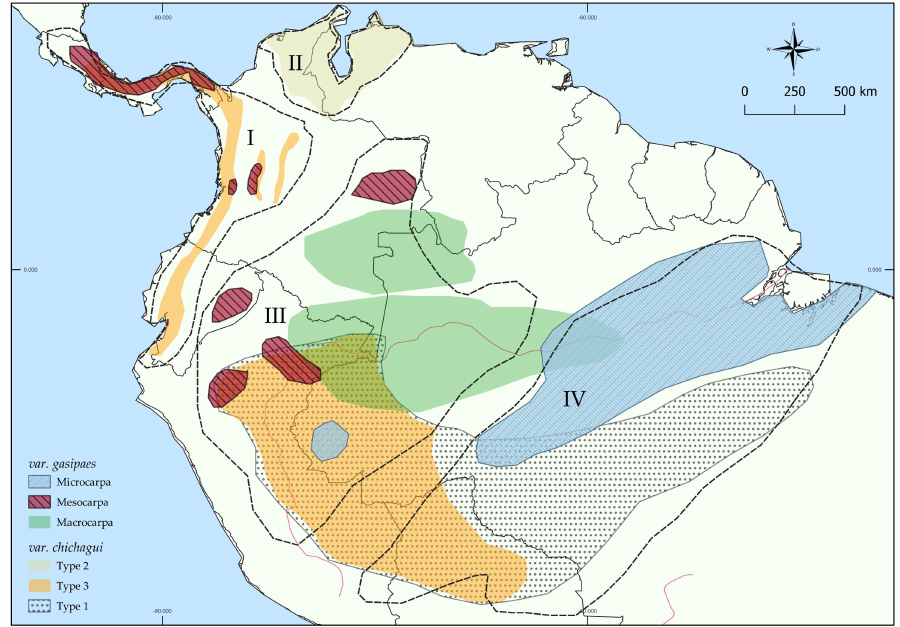
Figure 1. Distribution of B. gasipaes through Central and South America (adapted from Clement et al. [18] and Hern á ndez-Ugalde et al. [20]). The dashed lines comprehend the four main complexes: I. Occidental group: composed of representants of var. chichagui (Upala, Azuero, Dar í en, Chontila, and Chinamato) and var. gasipaes (Utilis landrace); II. Maracaibo group: comprehend- ing B. caribaea and B. macana (outgroups); III. Upper Amazonia: composed of Caquet á , Putumayo (Yurimaguas population), Vaup é s, Inirida, Ayacucho, Pastaza, Tigre, and Juru á landraces; IV. Eastern Amazonia: Par á and Temb é landraces, and var. chichagui Acre and Xing ú